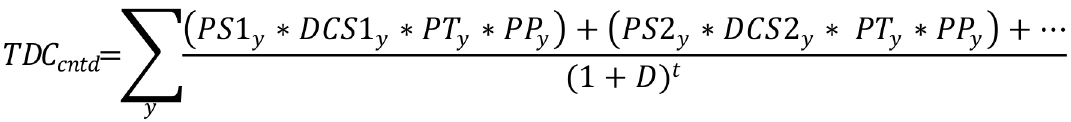
Fig 2. General formula for calculating out-of-pocket payments. TDC = Total out-of-pocket payments (in US$ 2005), NTD = Neglected tropical disease, c = Country, y = Year, PS1 = Number of persons with sequela 1 of NTD, PS2 = Number of persons with sequela 2 of NTD, DCS1 = Annual out-of-pocket payments relating to sequela 1 (per WHO region or country), DCS2 = Annual out-of-pocket payments relating to sequela 2 (per WHO region or country), PT = Percentage of patients treated, PP = Percentage of patients paying for the treatment, D = Annual discount rate, t = Time